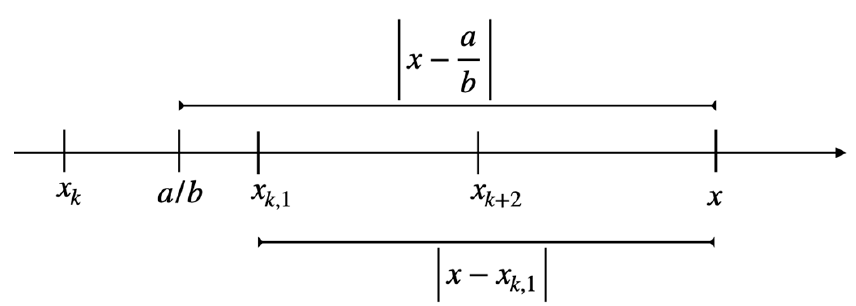
The geometric situation from Figure 16 reveals contradiction to a / b being a best approximation of the first kind to x and b > q k + 1 + q k . (cid:3) ( case 3 )